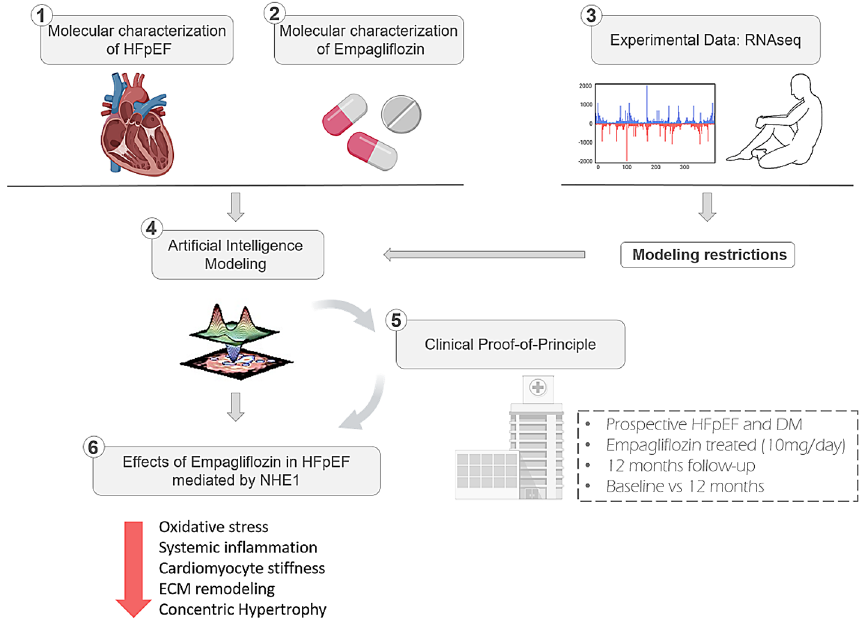
Figure 3. Graphical representation of the experimental designed followed in this study. First, we characterized the molecular profile of HFpEF and Empagliflozin (Panels 1 and 2). Next, we used experimental, RNAseq data to frame the behaviour of the future mathematical models (Panel 3). Then, we built a series of algorithms based on artificial intelligence techniques to elucidate the most prominent mechanism of action at play that could describe the clinical improvements observed in patients (Panel 4). Finally, we validated these findings in a small cohort of patients before and after being treated with empagliflozin, to delineate a specific signalling cascade (Panels 5 and 6). ECM: Extracellular matrix; HFpEF: heart failure with preserved ejection fraction; DM: diabetes